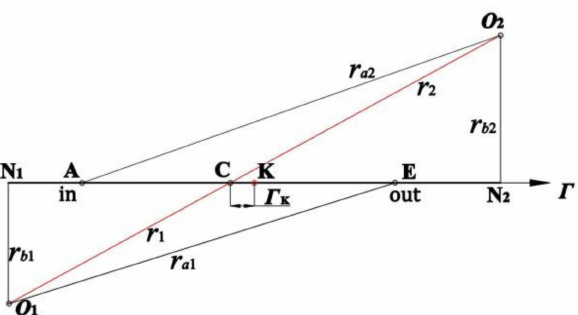
Figure 4. Normalized coordinates of the line of action. A—the meshing-in point; C—the pitch point; E—the meshing-out point; K—arbitrary contact point on the line of action; N 1 —ideal meshing-in point; N 2 —ideal meshing-out point; r1—pitch radius of the pinion; r2—pitch radius of the gear; ra1—radius of addendum of the pinion; ra2—radius of addendum of the gear; rb1—base radius of the pinion; rb2—base radius of the